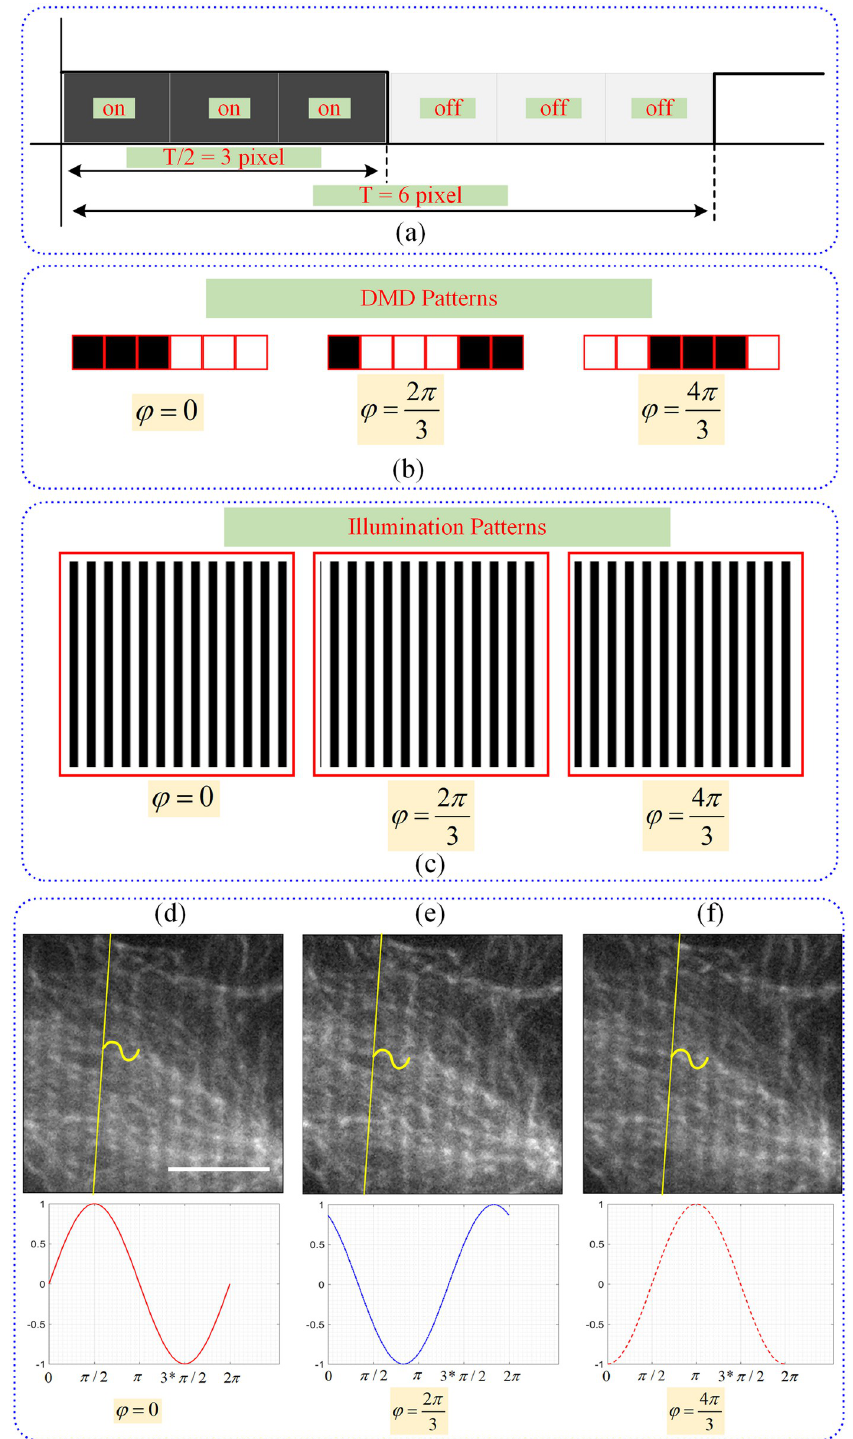
Fig 3. Generating SIM illumination patterns with the DMD chip. (a) Representation of six consecutive DMD mirrors that used for creating illumination patterns. (b) Binary patterns loaded on the DMD in one period of six pixels 4 p , respectively. (c) Corresponding illumination patterns with the same angular at three different phases of φ ¼ 0 ; 2 p 3 3 4 p orientation and phase values of φ ¼ 0 ; 2 p , respectively. Cos7 cells were labeled with Alexa-488 (alpha-tubulin, 3 3 microtubule marker). Microtubule images acquired using three different illumination patterns with the phase values of (d) φ = 0, (e) φ ¼ 2 p , (f) φ ¼ 4 p are shown. The graphs and sketches below the images show the corresponding 3 3 sinusoidal illumination